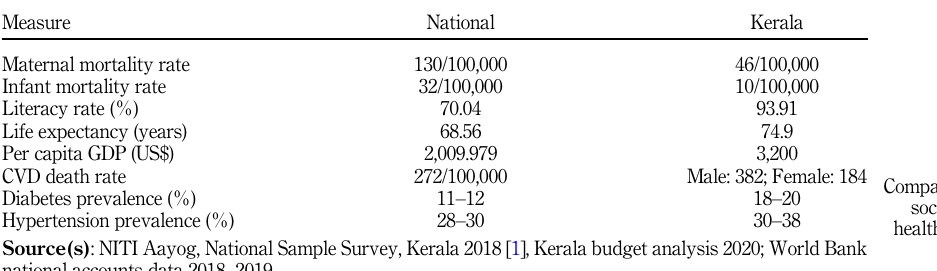
Table 1. Comparison of various socio-economic and health-care